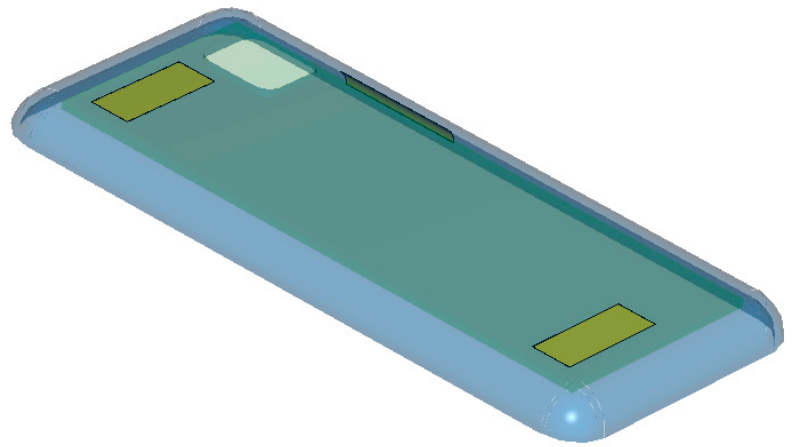
Figure 1. A bird’s eye-view of the in-fashion 5G mobile handset.